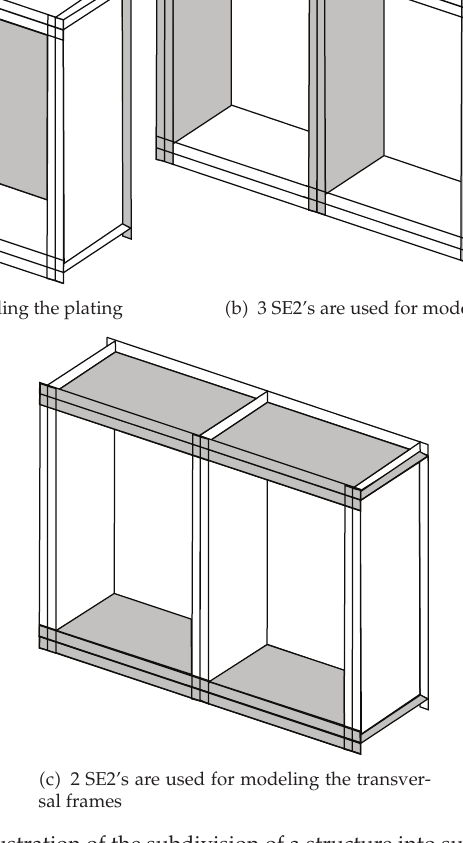
Figure 9: Illustration of the subdivision of a structure into